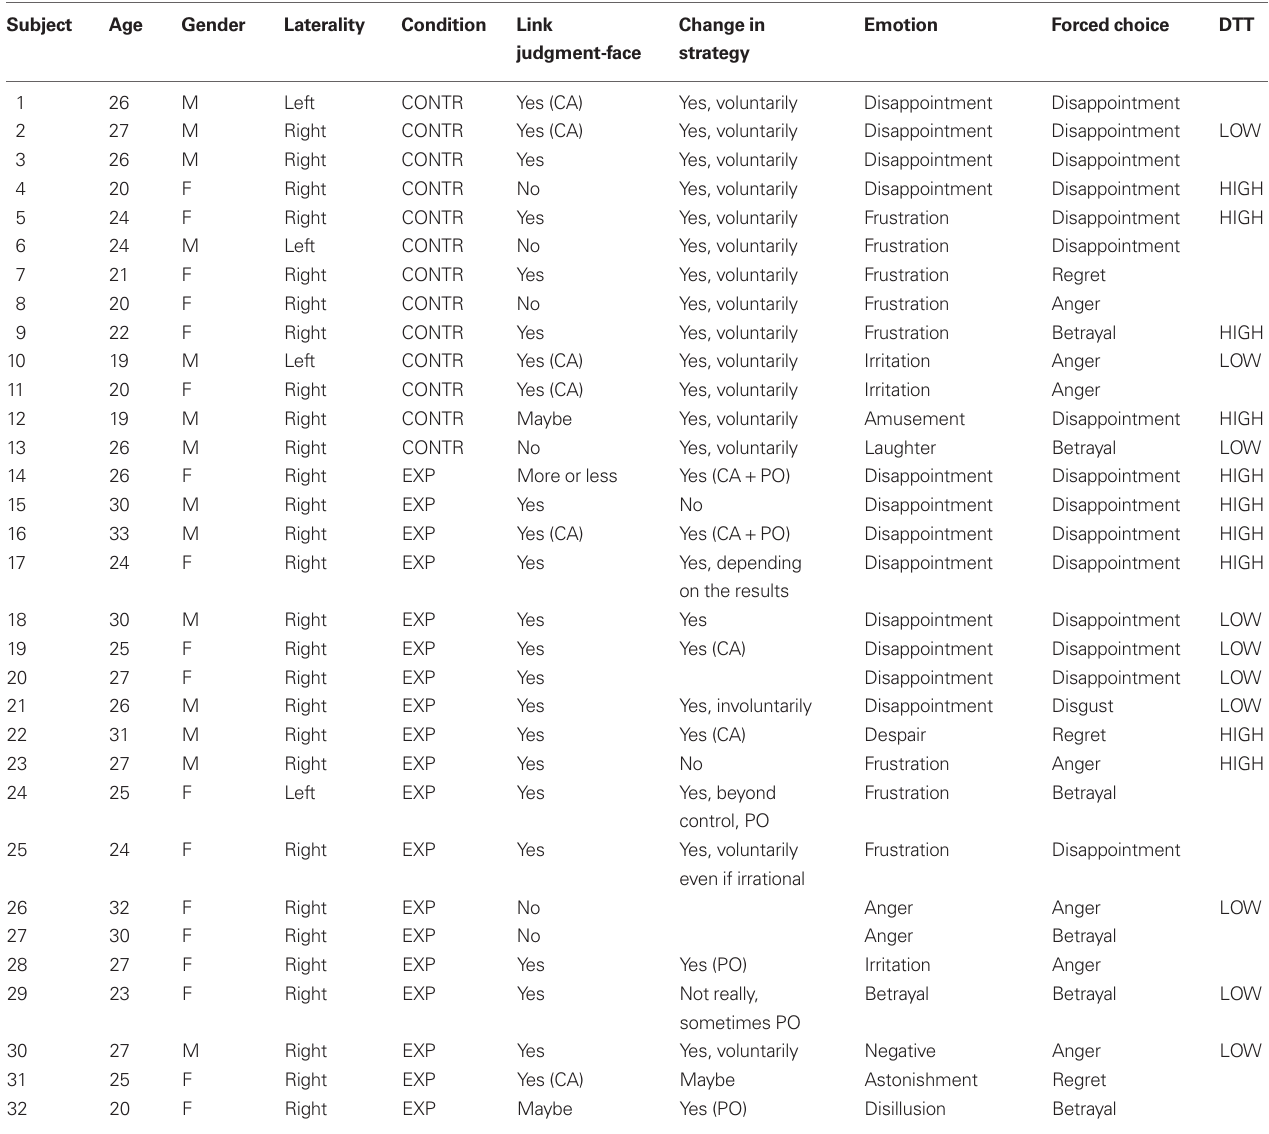
Table A1 | Summary of subjects and individual responses to the